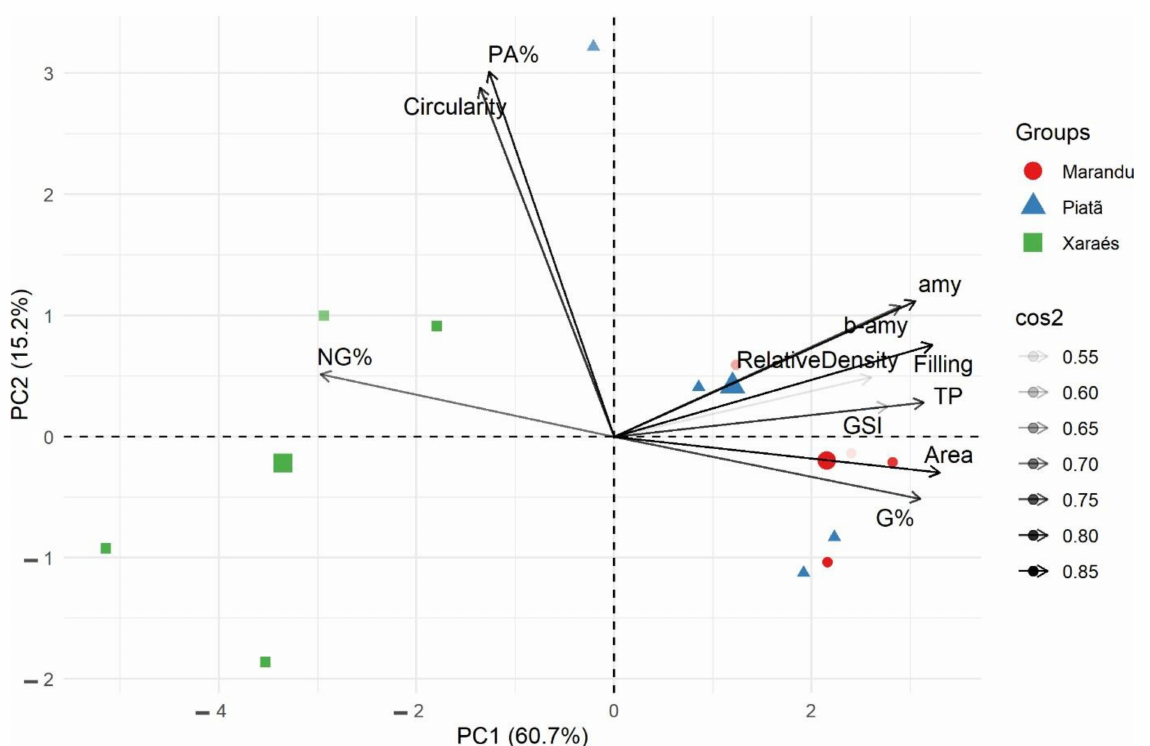
Figure 4. Biplot of the principal components comprising the following variables: area, round- ness, density, filling percentage, germination speed index, germination percentage, PT—total pro- teins, amy = α -amy alpha amylase, b-amy = β -amy beta amylase, normal and abnormal, and non- germinated Brachiaria brizantha cultivar seedlings. cos2—importance of the variable in defining the principal component (PC); PC1—first principal component; PC2—second principal